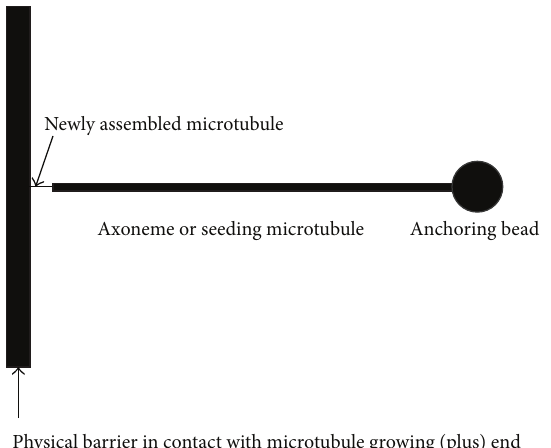
Figure 2: Schematic representation of the experimental setup for microtubule assembly. The anchoring bead was trapped in optical tweezers. Refer to [10, 11] for more details about the experimental apparatuses and reaction